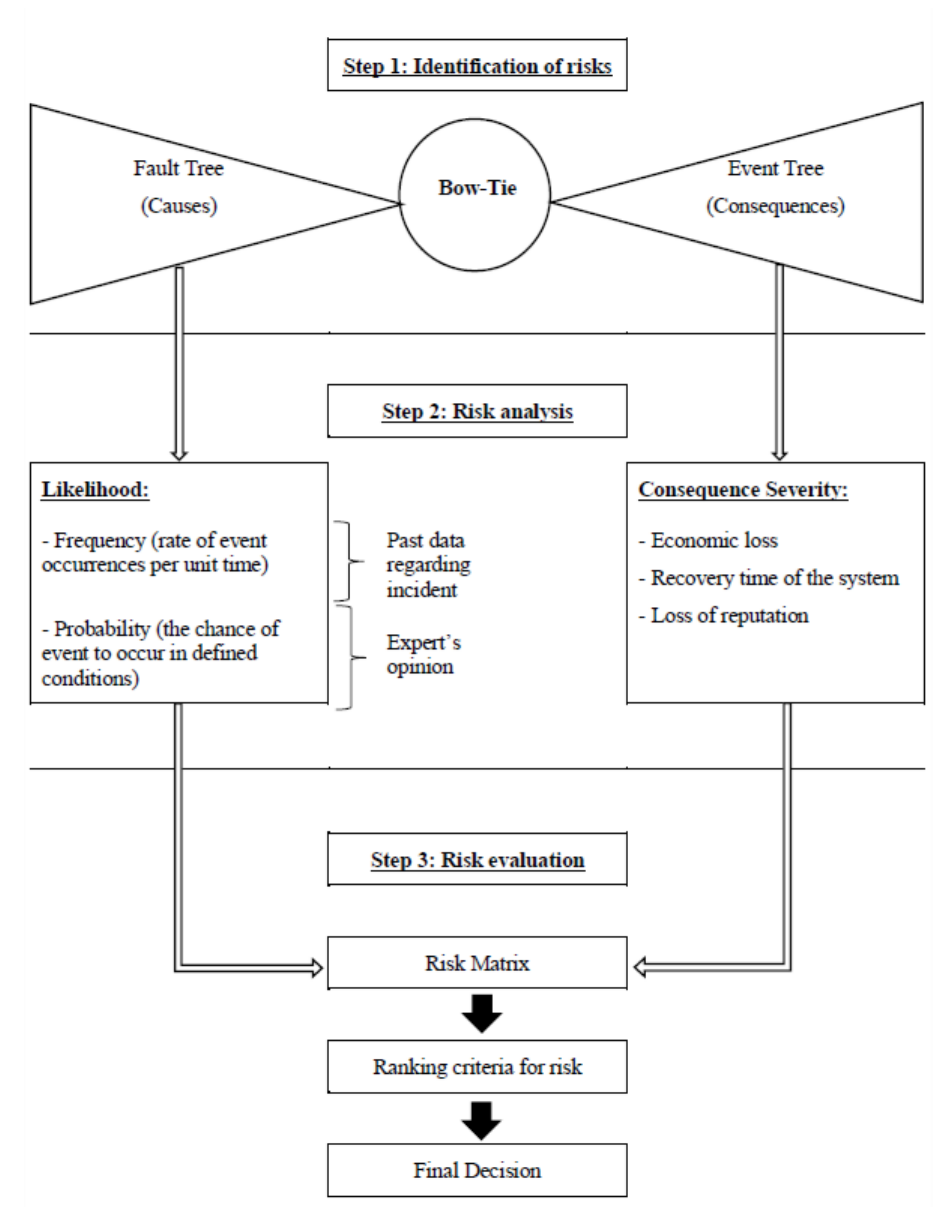
Figure 5. Proposed framework for cybersecurity in telemedicine.